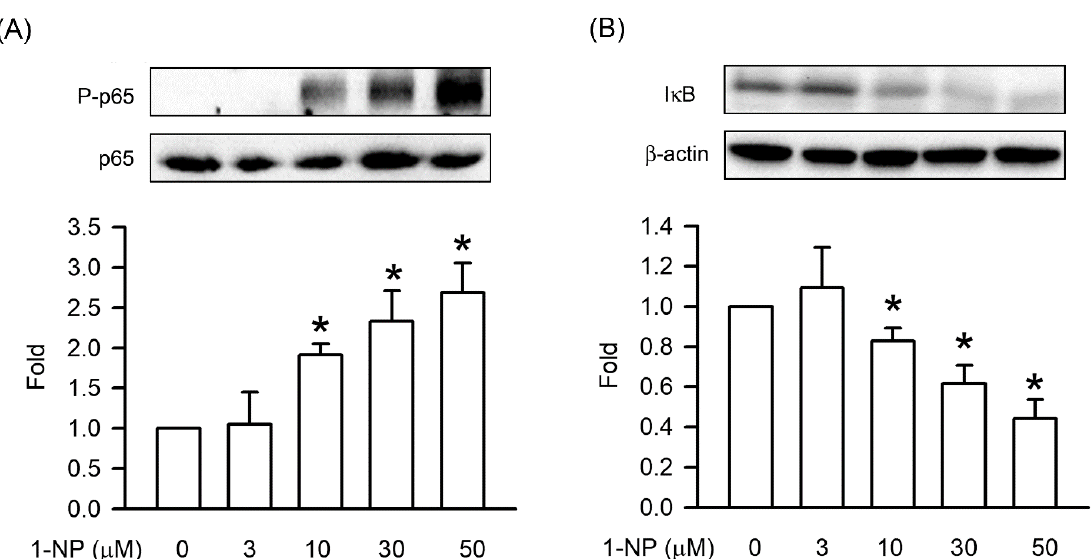
Figure 4. NF κ B p65 phosphorylation and I κ B degradation were induced by 1-NP in RAW264.7 macrophages. The level of NF κ B p65 phosphorylation ( A ) and I κ B degradation ( B ) was measured by a Western blotting assay. Results are expressed as means ± SD ( n = 3). * p < 0.05 is considered significant, compared with the control group, which indicated treatment with 1-NP at 0 µ M.